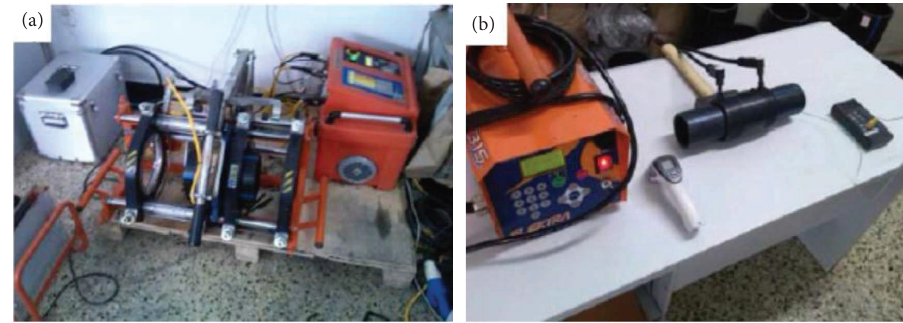
Figure 9: Connection methods between PE pipes: (a) thermal fusion welding and (b) electric fusion welding